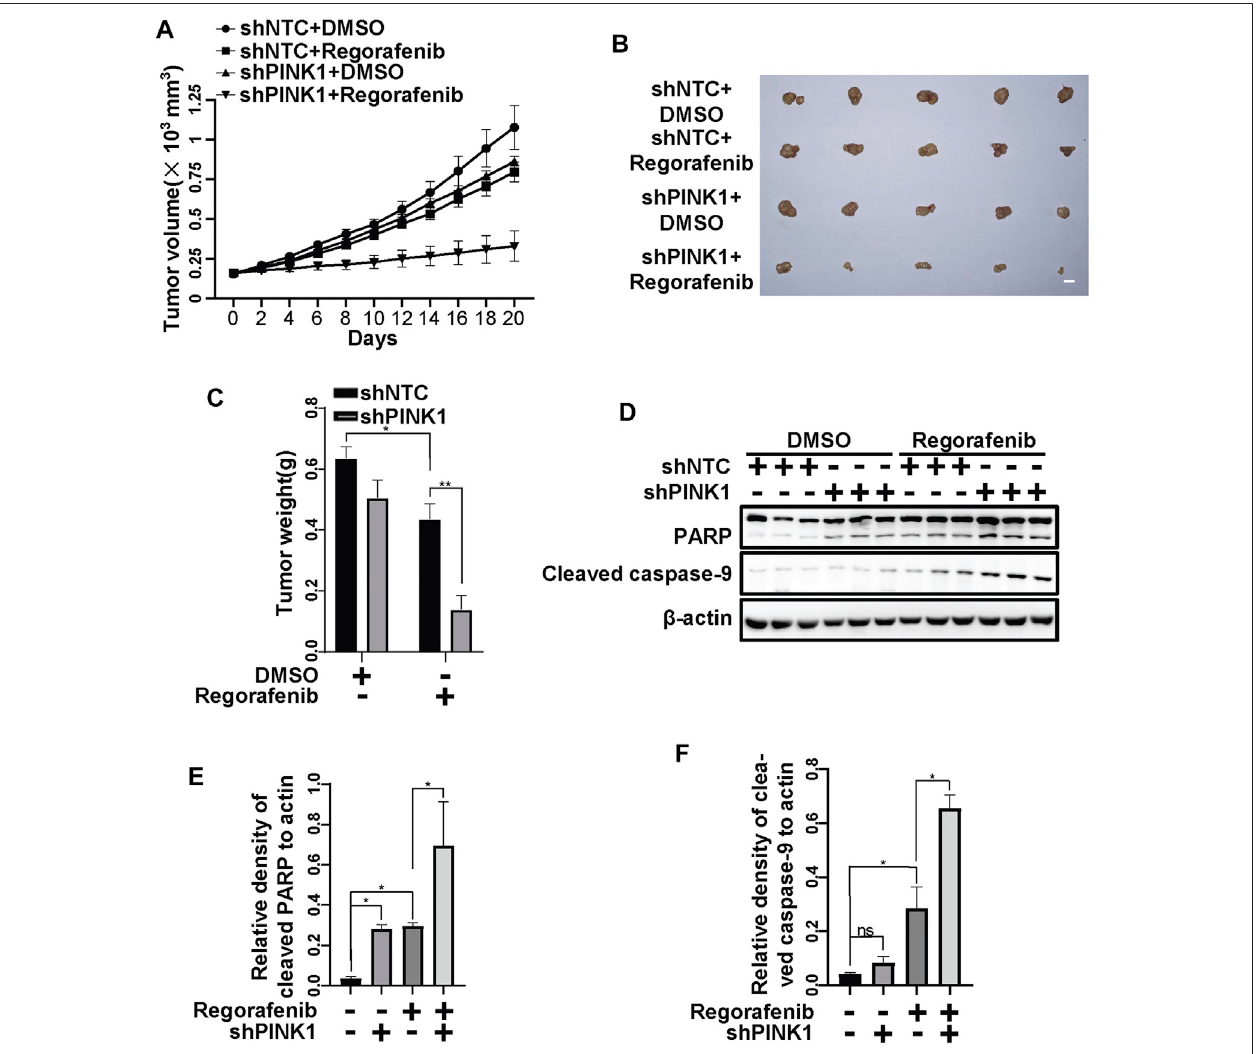
FIGURE 9 | Targeting PINK1 effectively promotes regorafenib repressive effects on tumor growth in vivo . (A) Growth curves of tumors that stably expressed shNTCsor shPINK1in animals treatedwithor without regorafenib areshown. (B) Representative xenograft tumors at the endpoint are shown. (C) Thegraph shows the weight of tumors in each group ( n = 5, scale bar, 1 cm * p < 0.05, ** p < 0.01, two-way ANOVA and Tukey ’ s multiple comparisons test). (D) The cleavages of PARP and caspase-9 in tumor tissue from (A) were detected using immunoblot analysis. (E,F) The relative densities of cleaved PARP (E) and cleaved caspase-9 (F) were quanti fi ed, and the protein levels were normalized to the loading control ( β -actin). Values are the mean ± SEM from three independent experiments (* p < 0.05, two-way ANOVA and Tukey ’ s multiple comparisons test).